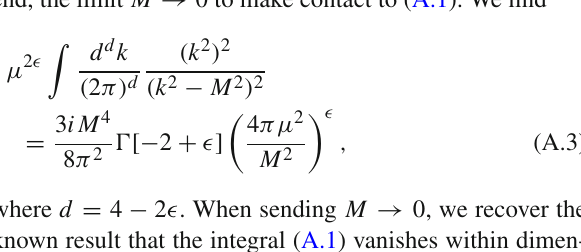
good agreement with N f 2 / 2, we do not write it explicitly. Here